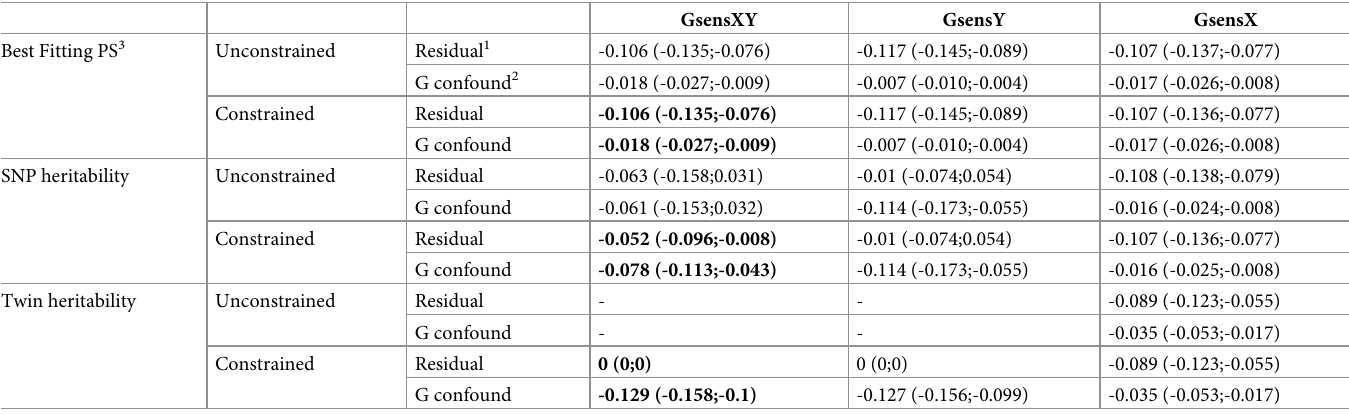
Table 3. Sensitivity analysis for